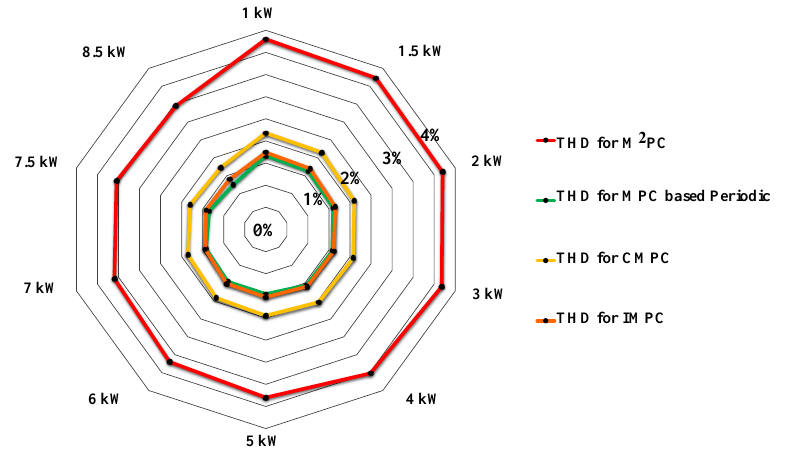
Figure 7. Total harmonics distortion of the voltage (THDv) for different MPC schemes at 5 kHz switching frequency (average).